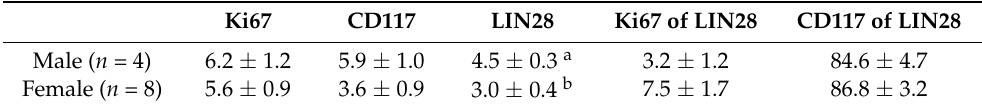
Different superscripts denote differences between sexes ( p <